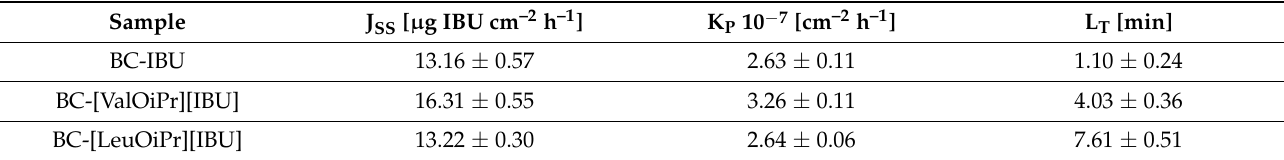
Table 3. Results for ibuprofen percutaneous permeation. Mean values ± standard deviation, n = 3.